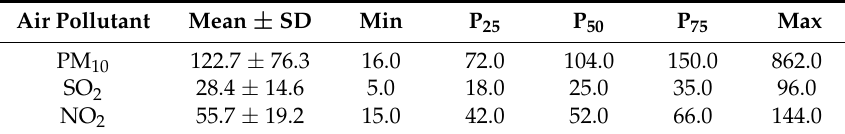
Table A1. Statistics of air pollution in Chengdu, 2011–2014.